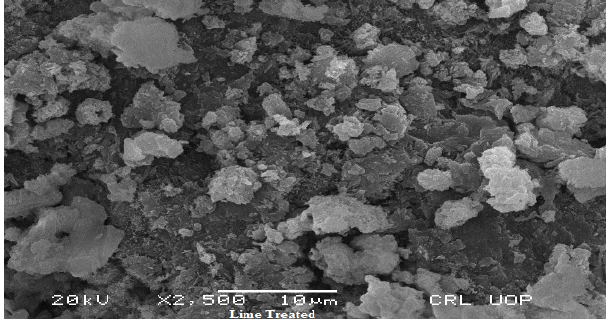
Figure 15. Lime-treated CR.